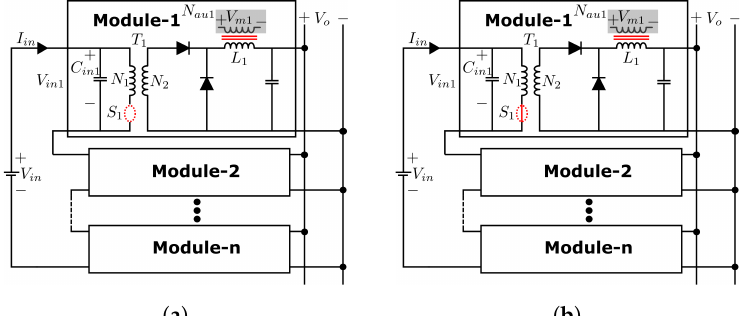
Figure 20. Circuit structure after switch fault for input-series–output-parallel PEC. ( a ) Open- circuit fault. ( b ) Short-circuit